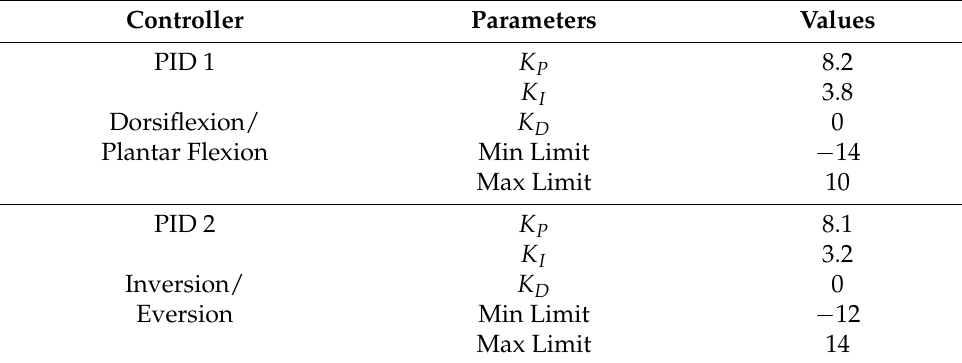
Table 1. PID parameters for ankle joint